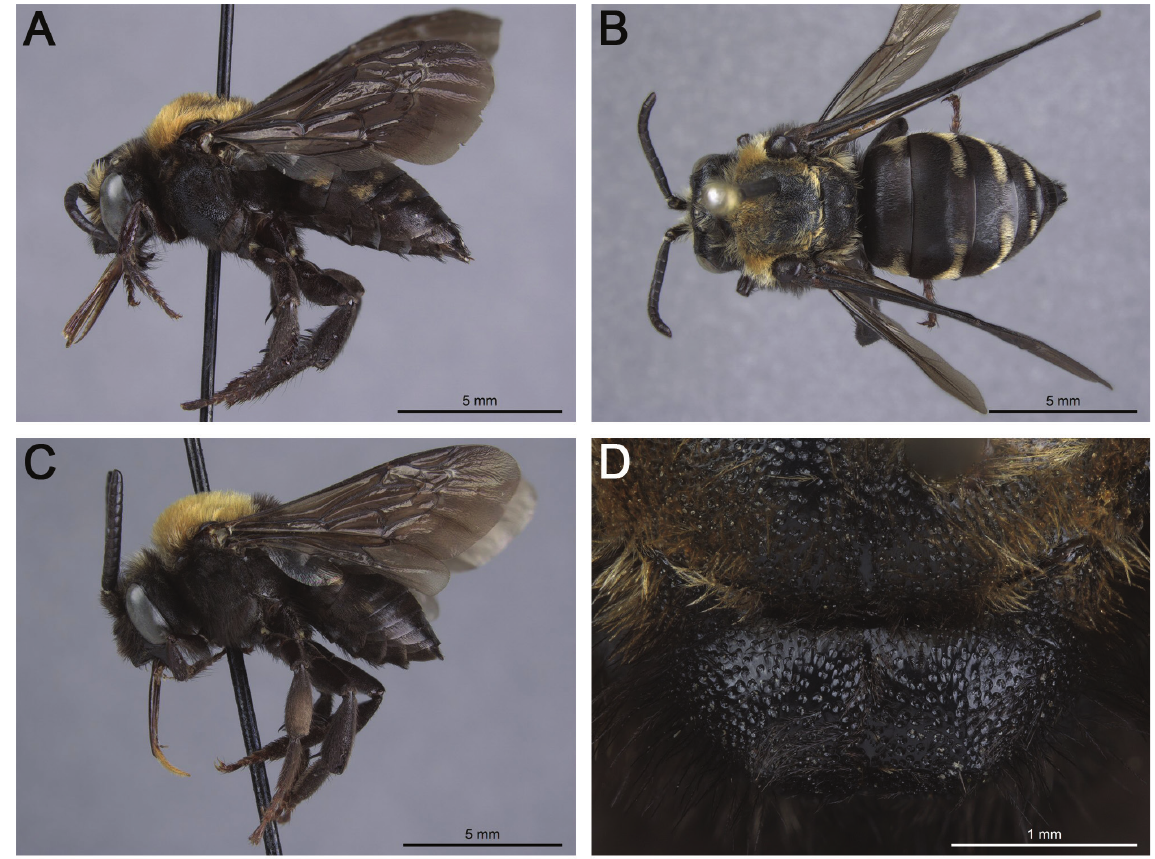
Fig. 15. Brachymelecta larreae (Cockerell, 1900). A, D. Female (CNC 891708). A . Habitus, lateral view. B . Female (CNC 891716), habitus, dorsal view. C . Male (CNC 899531), habitus, lateral view. D . Axillae and mesoscutellum, dorsal